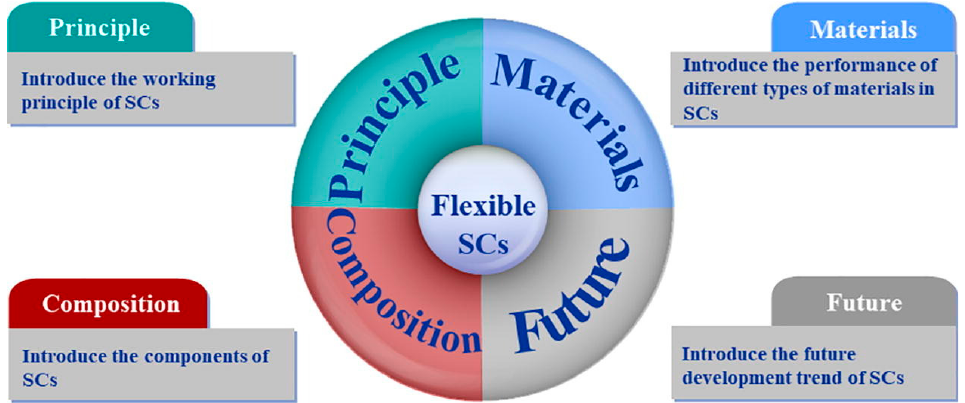
Figure 1. Main issues in flexible supercapacitors (SCs). Reproduced with permission from ref. [23]. Copyright 2015 Elsevier.